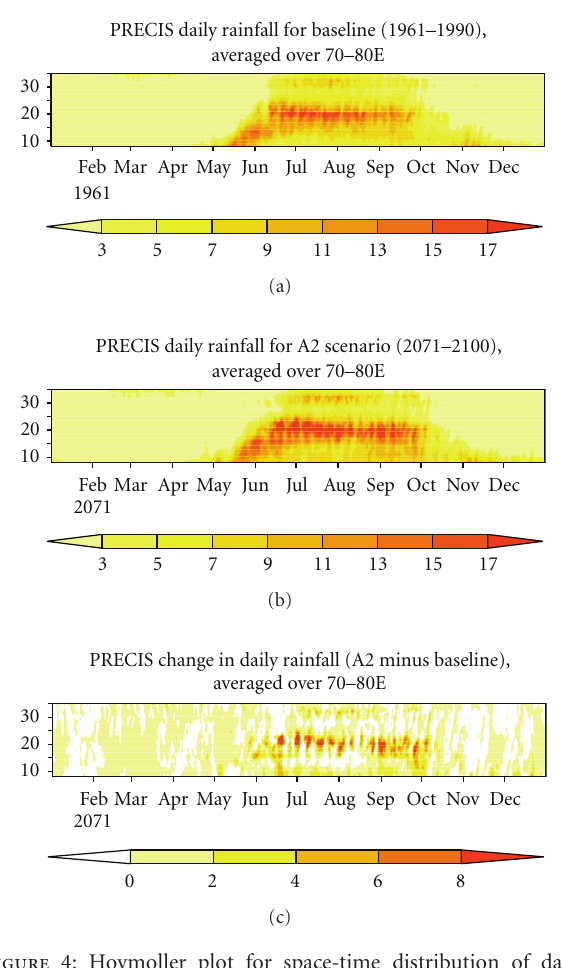
Figure 4: Hovmoller plot for space-time distribution of daily precipitation for baseline (1961–1990, (a)), A2 scenarios (2071– 2100, (b)) and change in precipitation in A2 scenarios with respect to baseline (A2 minus baseline, (c)), averaged over the region 70– 80 ◦